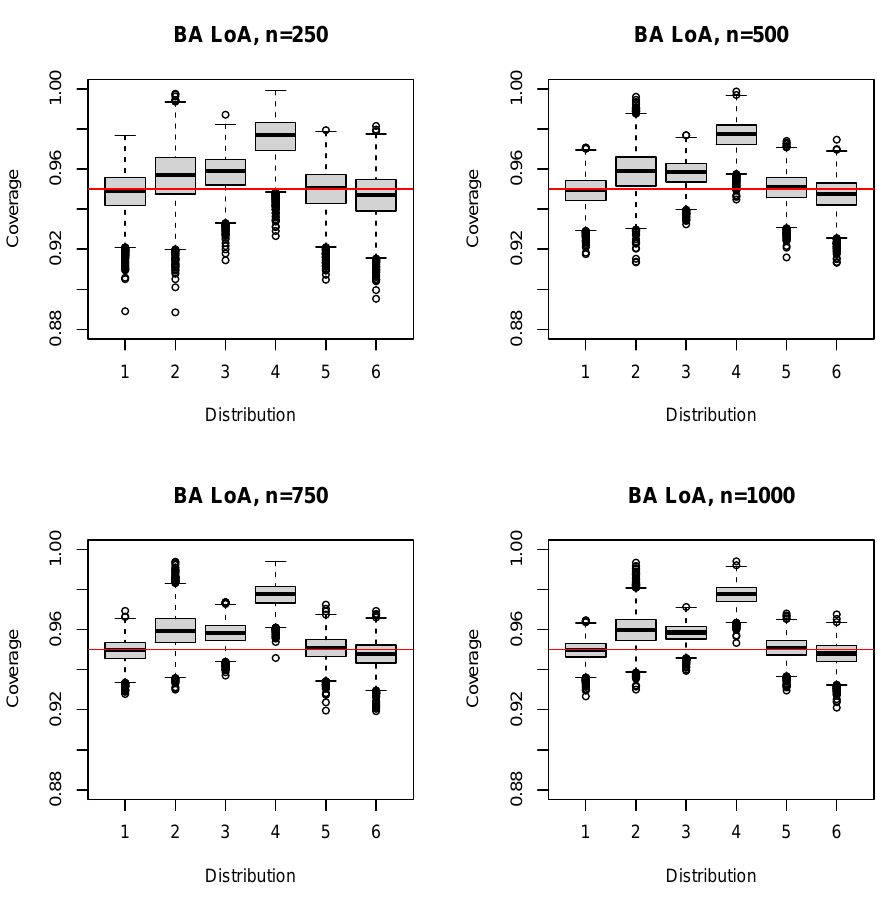
Figure 3. Boxplots of the coverage probability for the BA LoA and n = 250 ( 250 ) 1000.